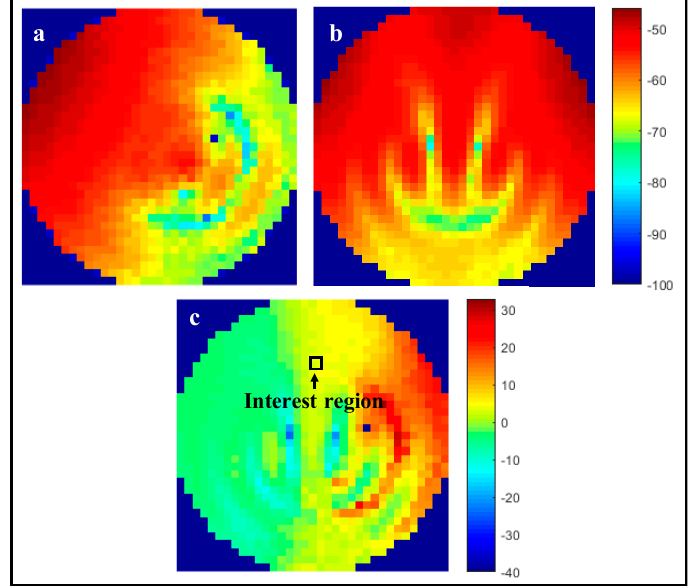
Figure 11. Power distribution inside the human brain phantom for ( a ) one transmitting antenna; ( b ) two transmitting antennas; and ( c ) difference of ( b , a ).